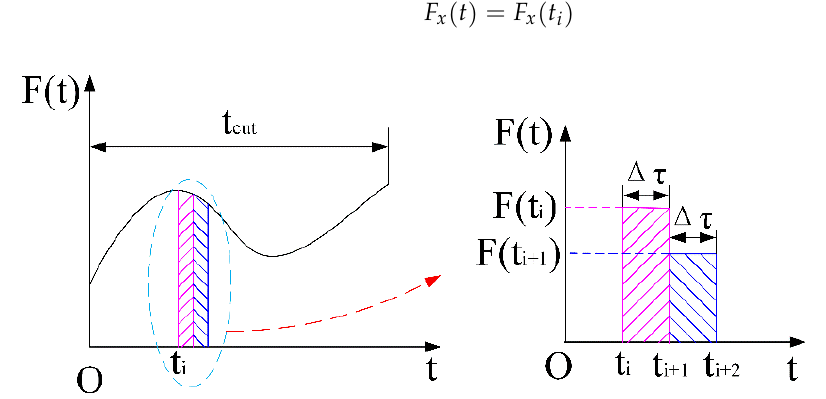
Figure 23. The discrete model of the milling force.